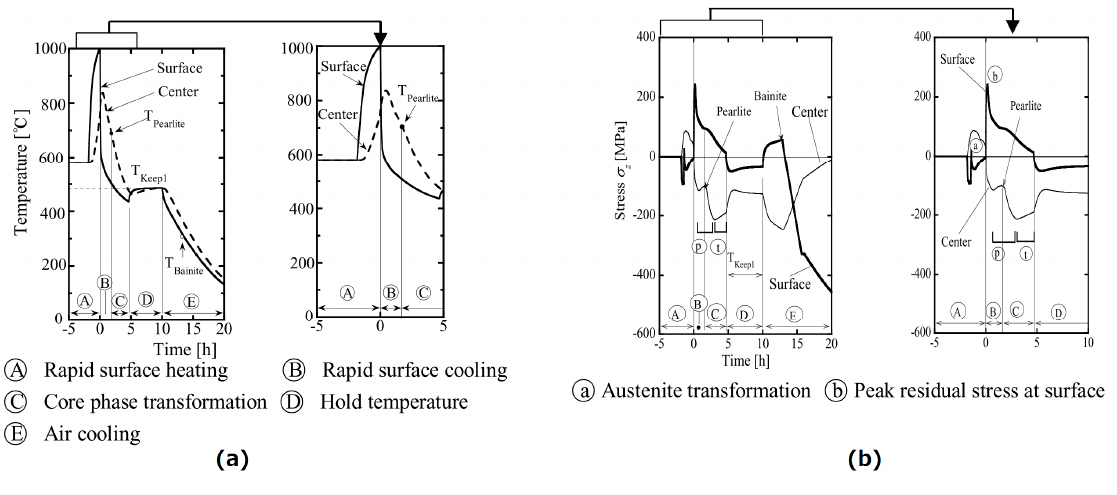
Figure 8. Non-uniform heating process and corresponding stress, σ z : ( a ) temperature at the center and surface; ( b ) stress, σ z , at the center and surface.